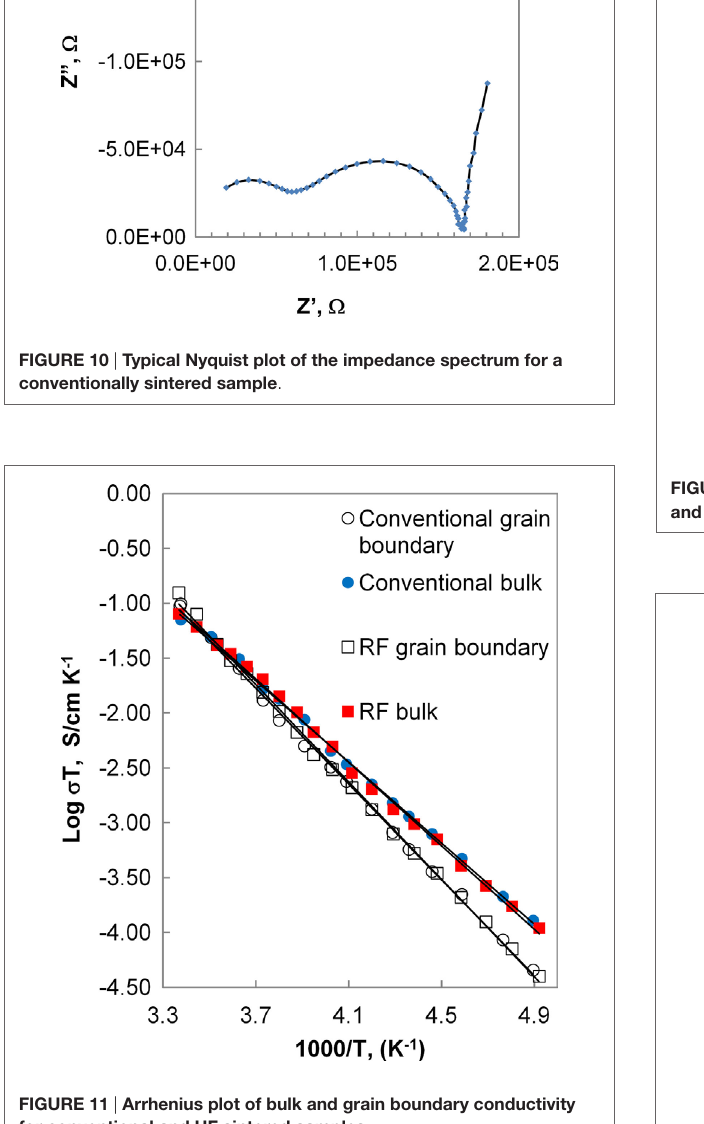
FigUre 13 | Proposed geometry of grain boundary electrowetting: (a) conventional sintering and (B) field-assisted sintering